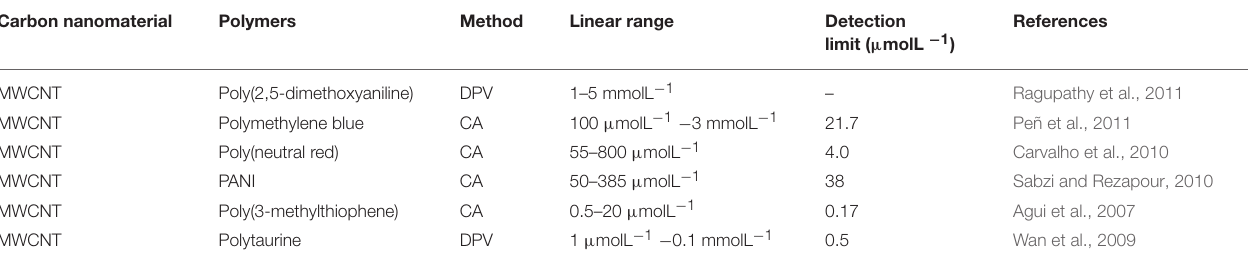
TABLE 2 | CP composites containing carbon nanomaterials have been successfully applied to electrochemical sensing. Carbon